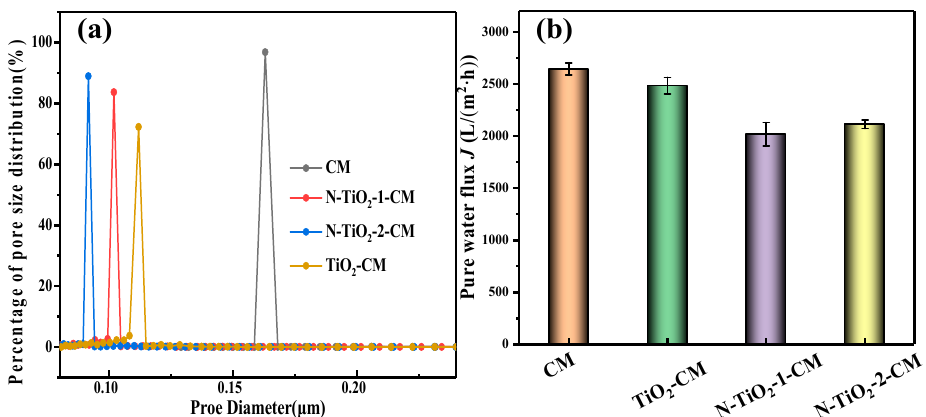
Figure 6. The pore size distribution ( a ) and pure water flux ( b ) of CM and N-TiO 2 -CM with different loading layers under a TMP of − 92 kPa.